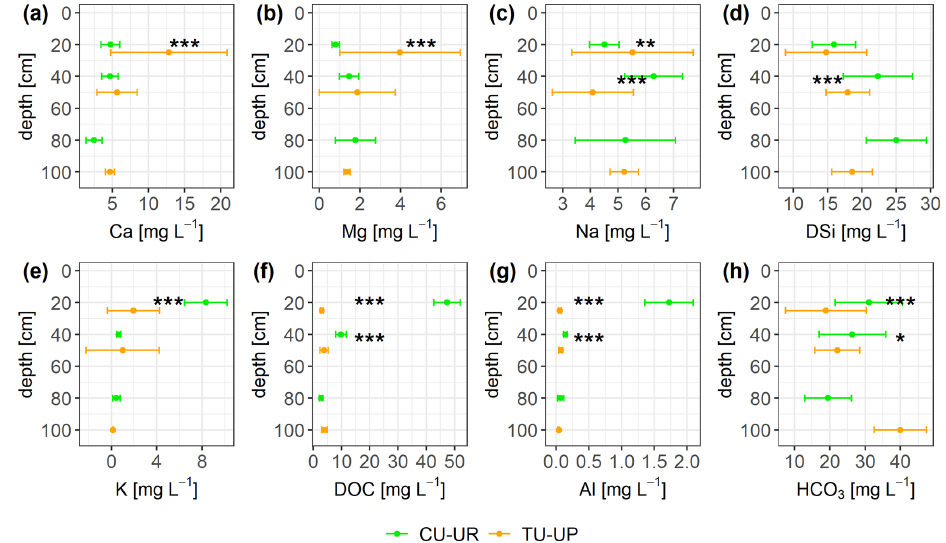
Figure 8. Solute concentrations (mean ± 2standard deviations) integrated over biweekly intervals for both soil profiles. The Mann–Whitney U test was applied for differences between vegetation types, with levels of significance ∗ , ∗∗ , and ∗∗∗ corresponding to p< 0 . 05, p< 0 . 01, and p< 0 .